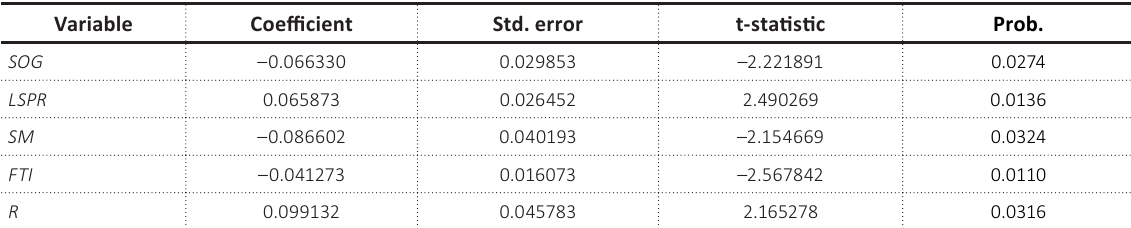
Table 5. The impact of each independent market structure variable on IRS